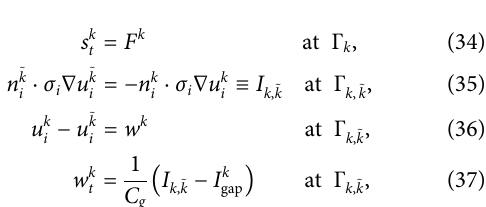
FIGURE 4 | Comparison of the solutions of the coupled (C) and splitting (S) approaches for the EMI model for a single cell. The left panel shows u e and the right panel shows u i .Furthermore, theupper panel shows thesolution oftheCapproach,the middle panel showsthe solutionofthe Sapproach, and thelower panel shows the absolute value of the difference between the two solutions. The solutions are collected at t (cid:2) 3.5 ms, and the plots show the solutions in a sheet in the center of the domain in the z -direction. The parameters used in the simulations are speci fi ed in Table 1 , and we use N it (cid:2) 1 in the S